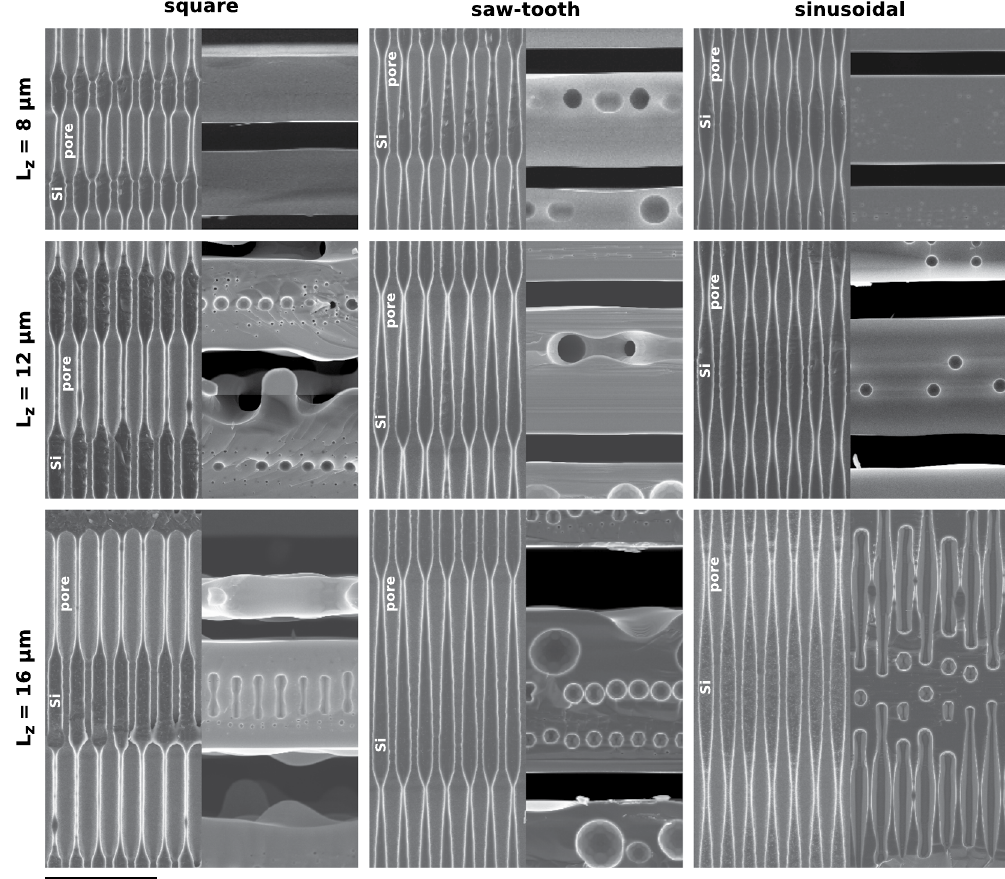
Figure 2. Scanning electron microscope (SEM) images, cross-section view, of samples with different pore profile before and after the high-temperature annealing. The scale bar, common to all panels, represents 10 µ